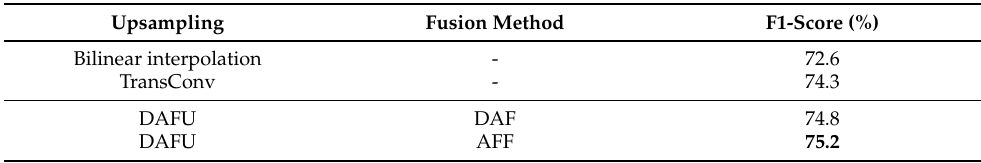
Table 6. Comparison results on CULane dataset.